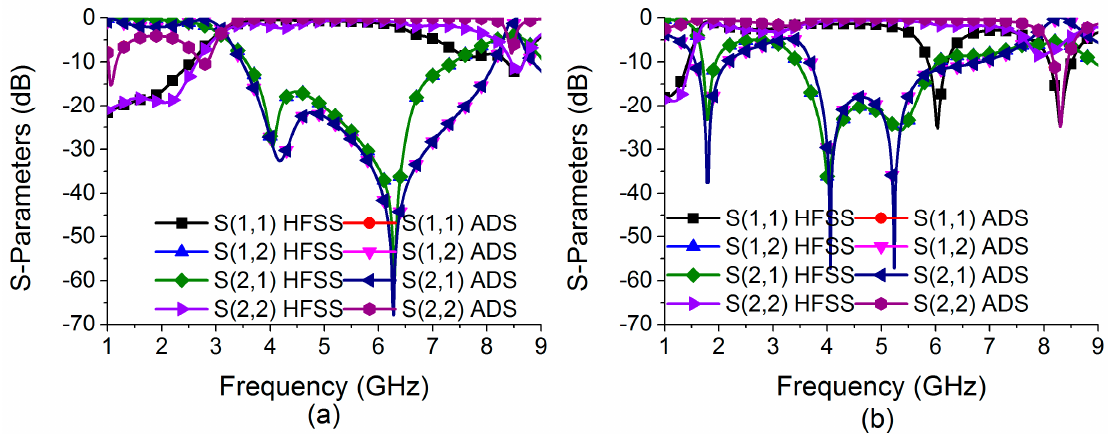
Figure 11. Comparison of HFSS and equivalent circuit model simulations in ( a ) mode 1 and ( b ) mode 2. Table 2. Element values of equivalent circuits.